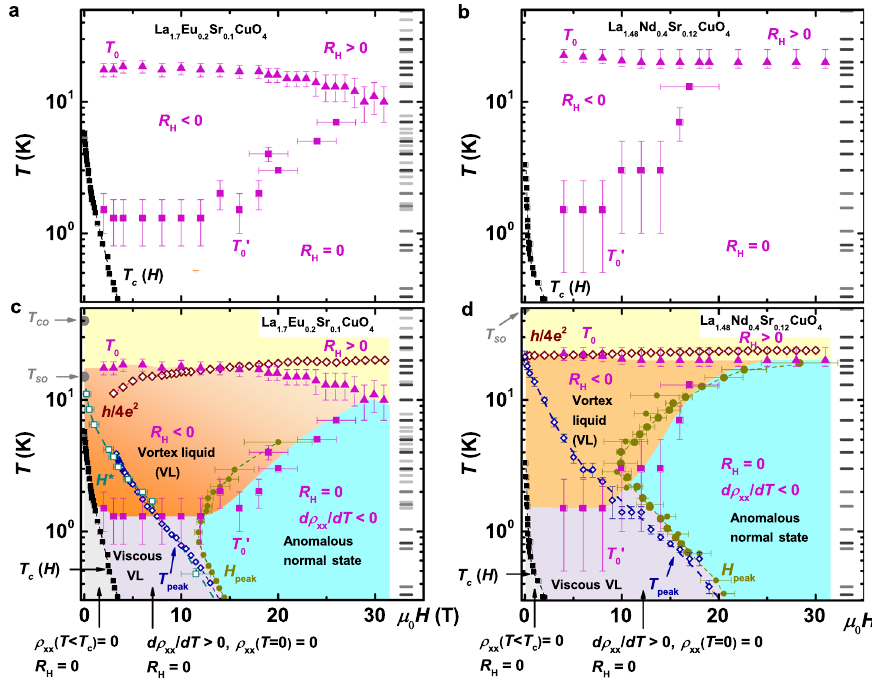
Fig. 1 In-plane Hall coef fi cient R H across the T – H phase diagram of striped cuprates. a , b Regions of T and H with different signs of R H for La 1.7 Eu 0.2 Sr 0.1 CuO 4 and La 1.48 Nd 0.4 Sr 0.12 CuO 4 , respectively. c , d Comparison of the results for R H to the other transport data 3,4 for La 1.7 Eu 0.2 Sr 0.1 CuO 4 and La 1.48 Nd 0.4 Sr 0.12 CuO 4 , respectively. T c ( H ) (black squares): boundary of the vortex solid in which ρ xx ( T < T c ) = 0 and R H = 0, as expected for a superconductor. The upper critical fi eld H c2 ( T ) ~ H peak ( T ); H peak ( T ) (dark green dots) are the fi elds above which the magnetoresistance changes from positive to negative 3,4 . The low- T , viscous vortex liquid (VL) regime (light violet) is bounded by T c ( H ) and, approximately, by T peak ( H ) (positions of the peak in ρ xx ( T ); open blue diamonds), H * ( T ) (crossover between non-Ohmic and Ohmic behavior 3 ; open royal squares), or H peak ( T ); here the behavior is metallic ( d ρ xx / dT >0) with ρ xx ( T → 0) = 0 and R H = 0. The fi eld-revealed normal state (blue) exhibits anomalous behavior: ρ xx ( T ) has an insulating, ln ð 1 = T Þ dependence 3,4 , but R H = 0 despite the absence of superconductivity. At high T (yellow), R H >0 and drops to zero at T = T 0 ( H ) (magenta triangles). In the ð H Þ (magenta squares), as the vortices become less high- T VL regime ( H < H peak ; dark beige), R H becomes negative before vanishing at lower T ¼ T 0 0 mobile. The h /4 e 2 symbols (open brown diamonds) show the ( T , H ) values where the sheet resistance changes from R □ /layer < R Q = h /4 e 2 at higher T , to R R T . Zero- fi eld values of T T T □ /layer > Q at lower SO and CO are also shown; PG ~ 175 K and~ 150 K for La 1.7 Eu 0.2 Sr 0.1 CuO 4 and La 1.48 Nd 0.4 Sr 0.12 CuO 4 , respectively 55 . All dashed lines guide the eye. In all panels, gray horizontal marks indicate measurement temperatures in different runs, the resolution of which de fi nes vertical error bars for T 0 and T 0 ; horizontal error bars re fl ect the uncertainty in de fi ning T 0 within our experimental resolution (see 0 0 Supplementary Fig. 3 for the raw R H ( H )